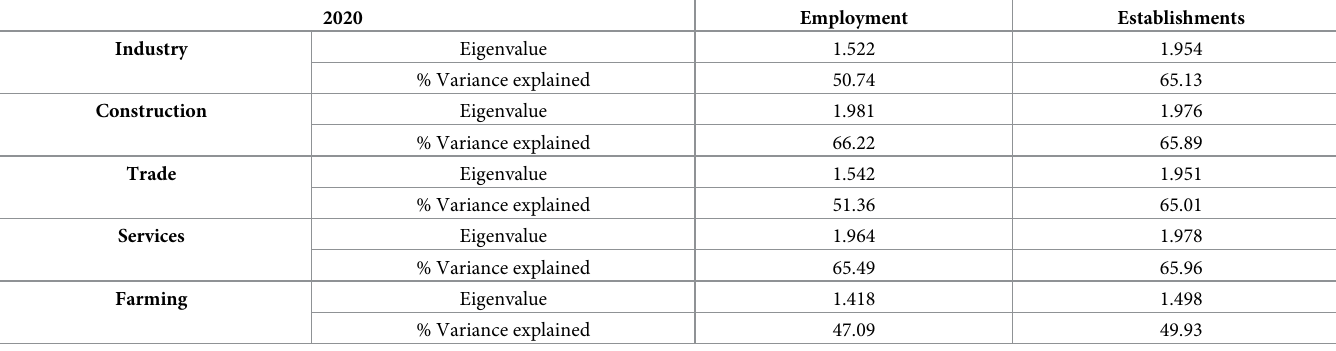
Table 2. Eigenvalues and the percentages of total variance explained for Factor 1 (F1) identified by the extraction of the main